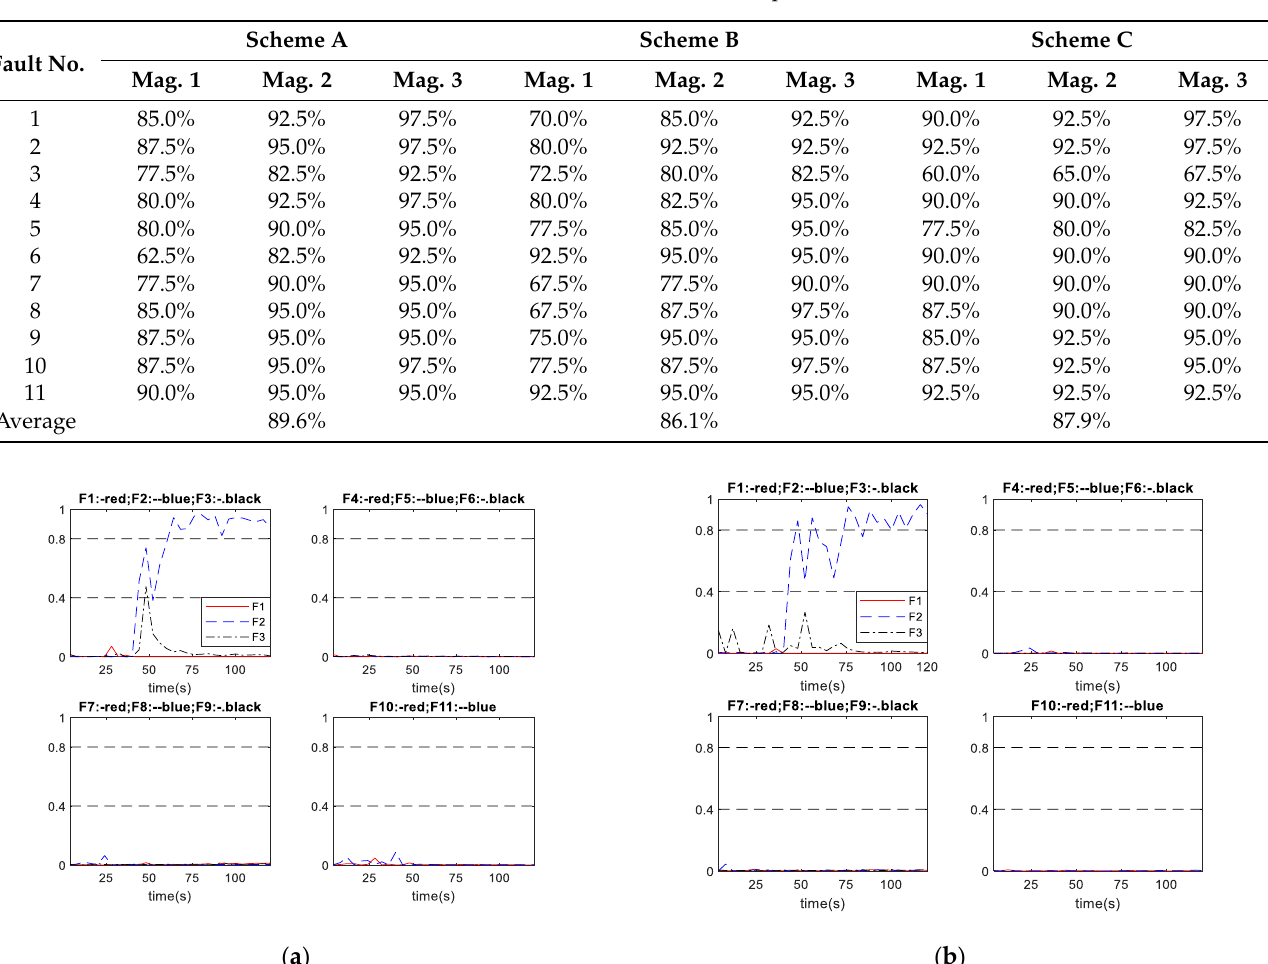
Figure 8. Diagnosis performance of scheme A ( a ) and scheme B ( b ) under abrupt fault No. 2 with relative magnitude of 1.67%.